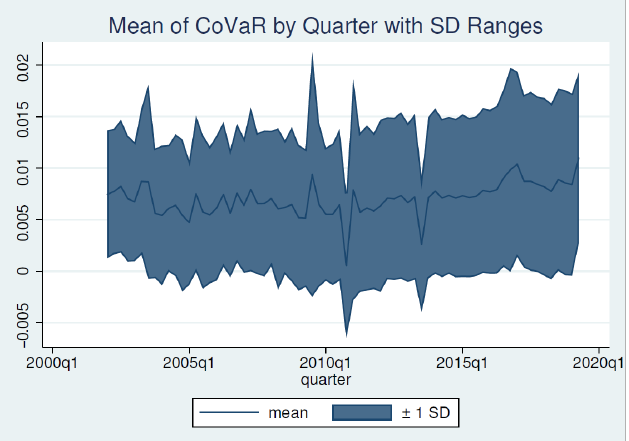
Figure A4. CoVaR. This graph displays the CoVaR time series in each quarter from the first quarter of 2002 to the second quarter of 2019. CoVaR is estimated following Adrian and Brunnermeier (2016) and extended to the second quarter of 2019. The sample contains 2018 bank-quarter